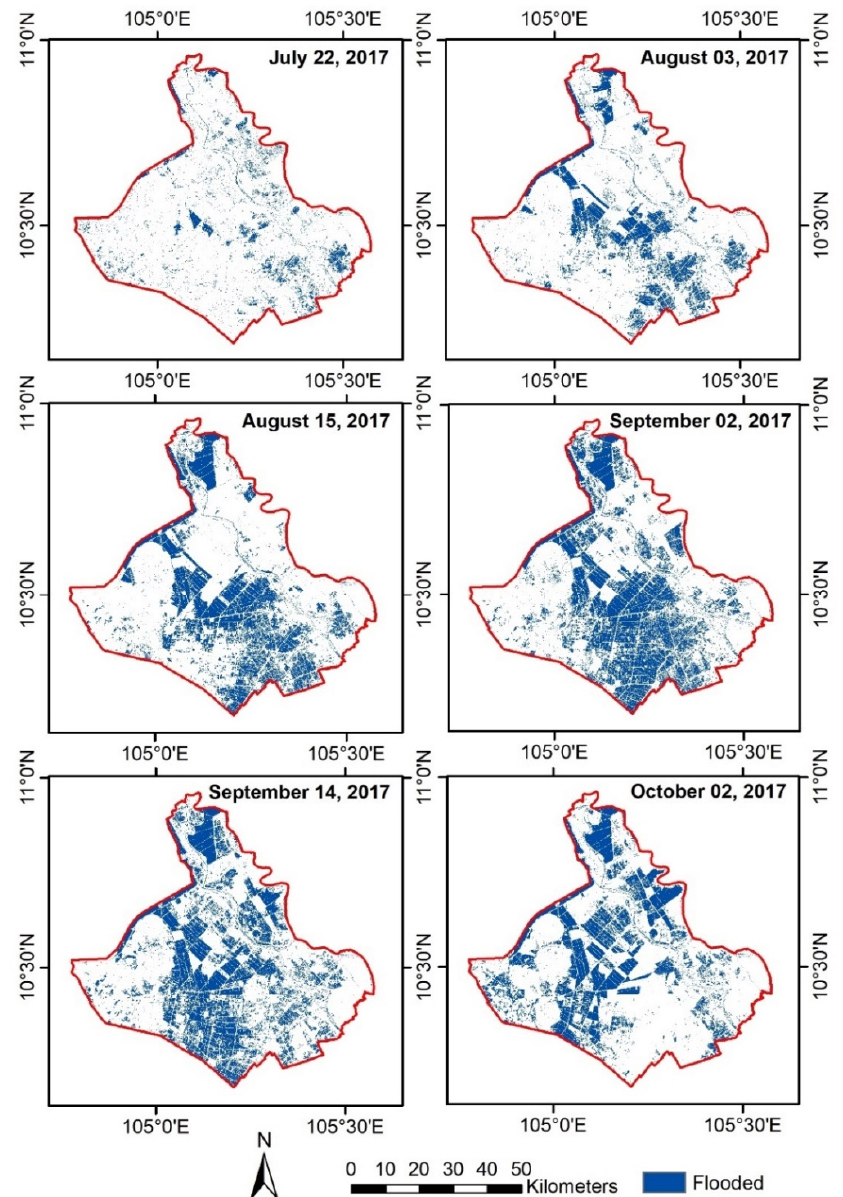
Figure 15. Flood extent maps during the flood event in 2017 using the change detection-based time series analyses on the derived surface water maps derived from the Sentinel-1 SAR data.